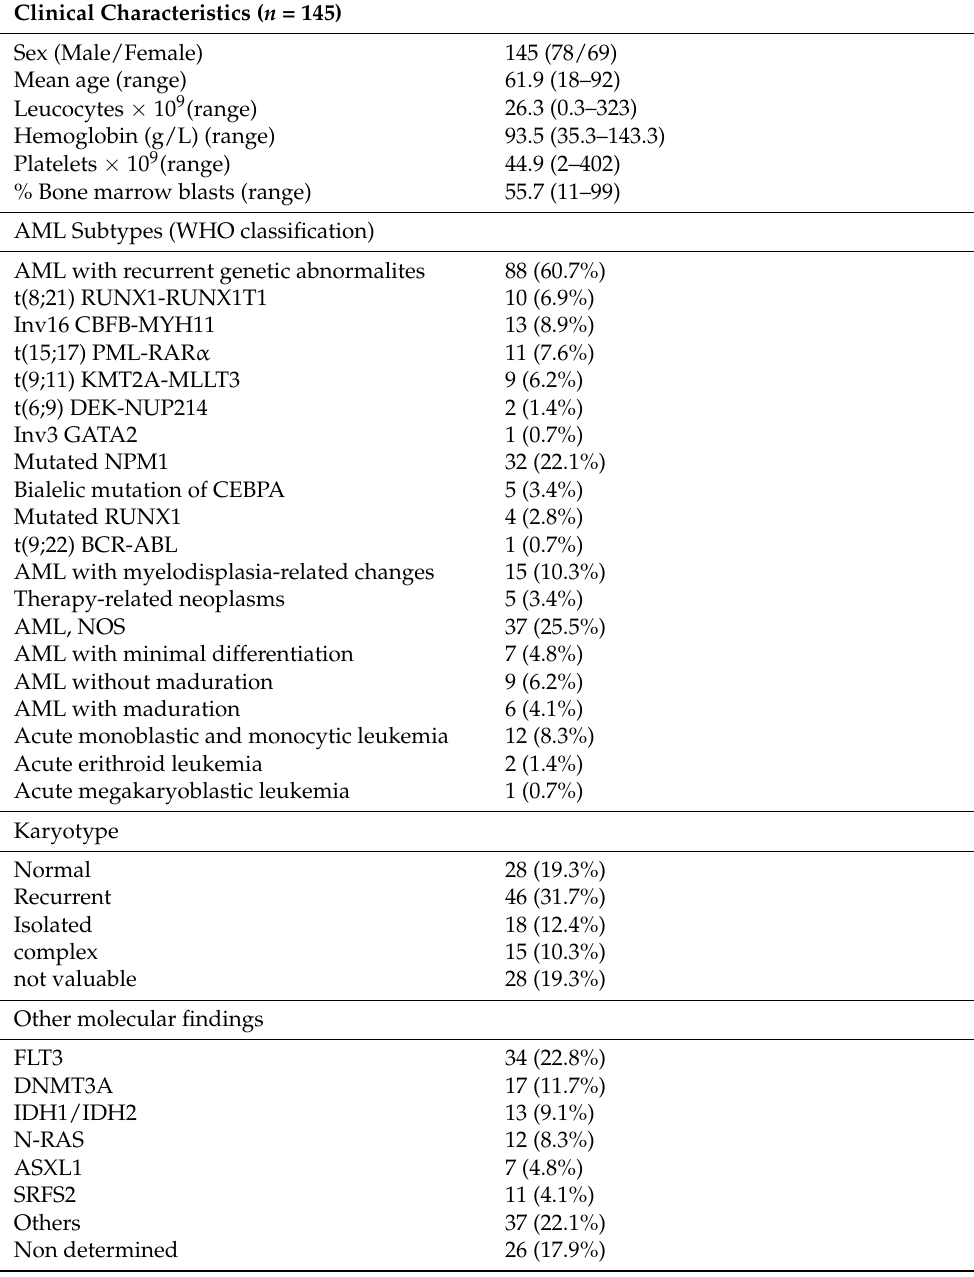
Table 1. Characteristics of the